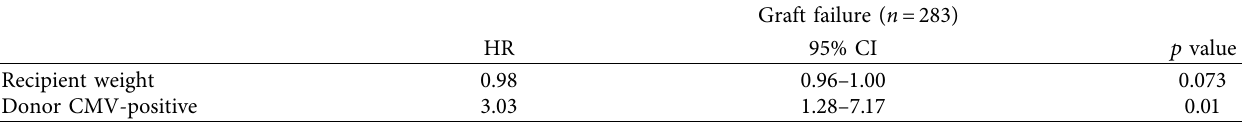
Table 4: Multivariable analysis after backward stepwise selection of predictors for graft failure in retransplantation.